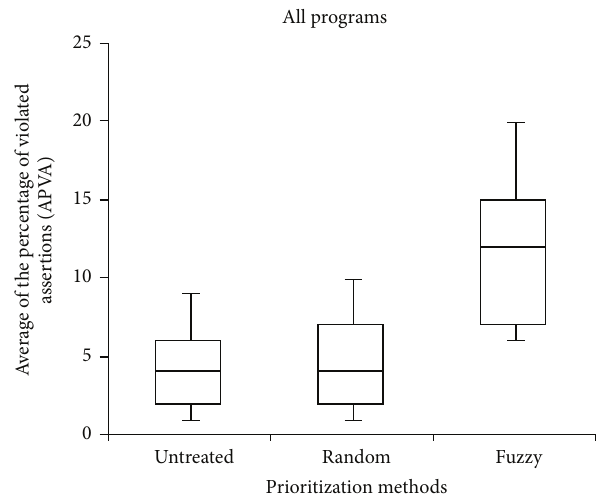
Figure 2: Average percentage of assertion violations achieved by each prioritization